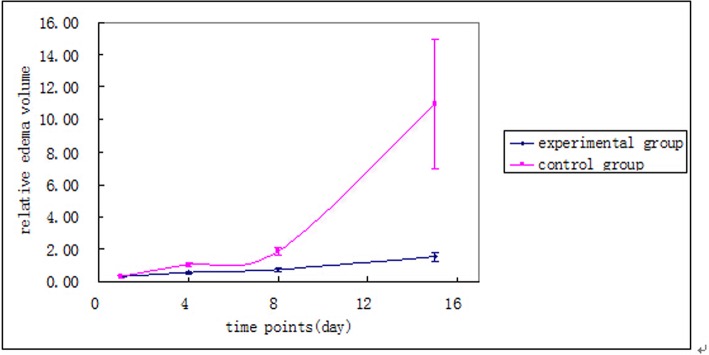
Trends in relative edema volume at admission, and on the 4th, 8th, and 15th day (or discharge).